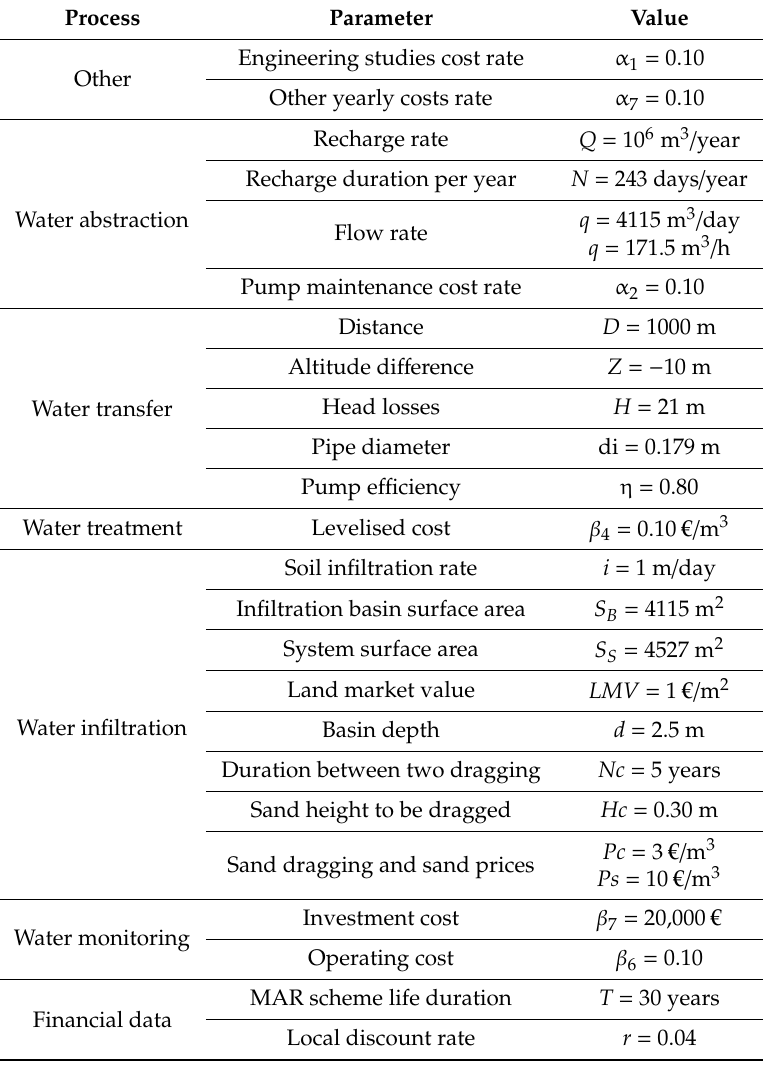
Table 3. Main characteristics of the MAR project on the VCP case